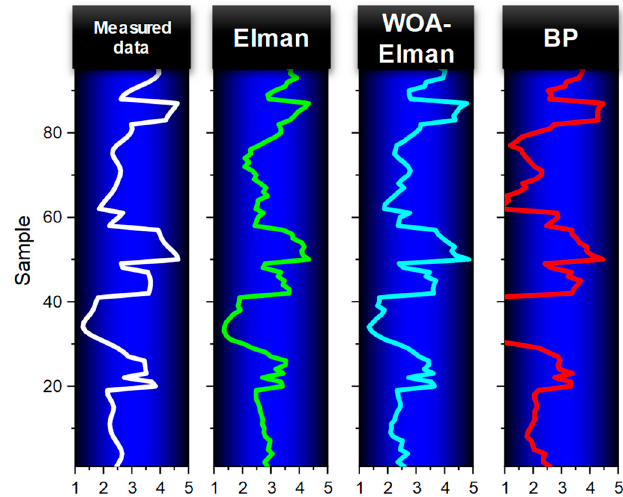
Figure 9. Logging curve of comparison between predicted value and real value of three machine learning models.